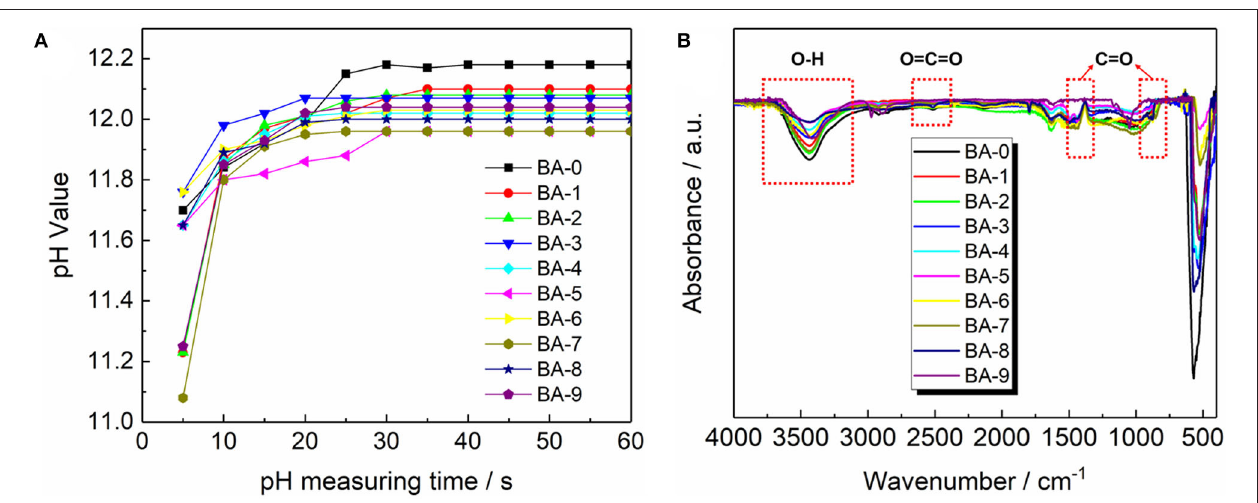
FIGURE 4 | (A) Plot of pH vs. the pH measuring time and (B) the FT-IR spectra of all the samples.